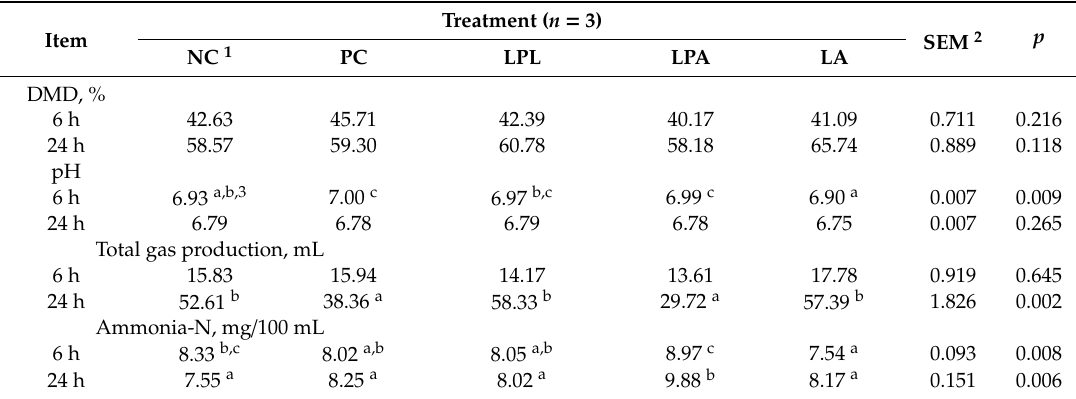
Table 3. E ff ects of LAB treated maize silage on in vitro rumen